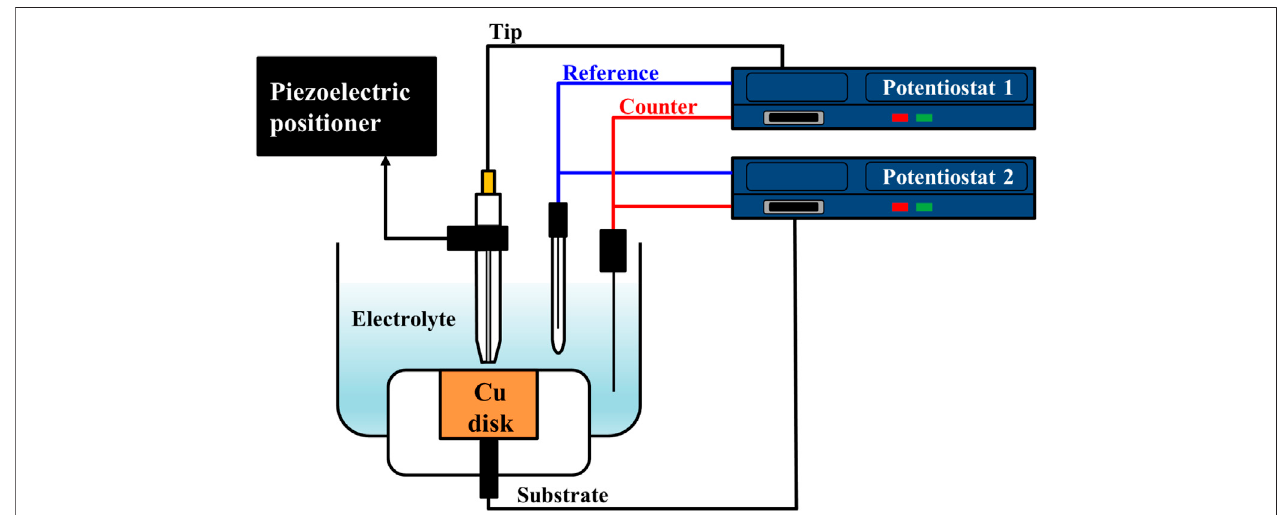
FIGURE 1 | Scheme of cell con fi guration for water electrolysis current measurement using SECM system.